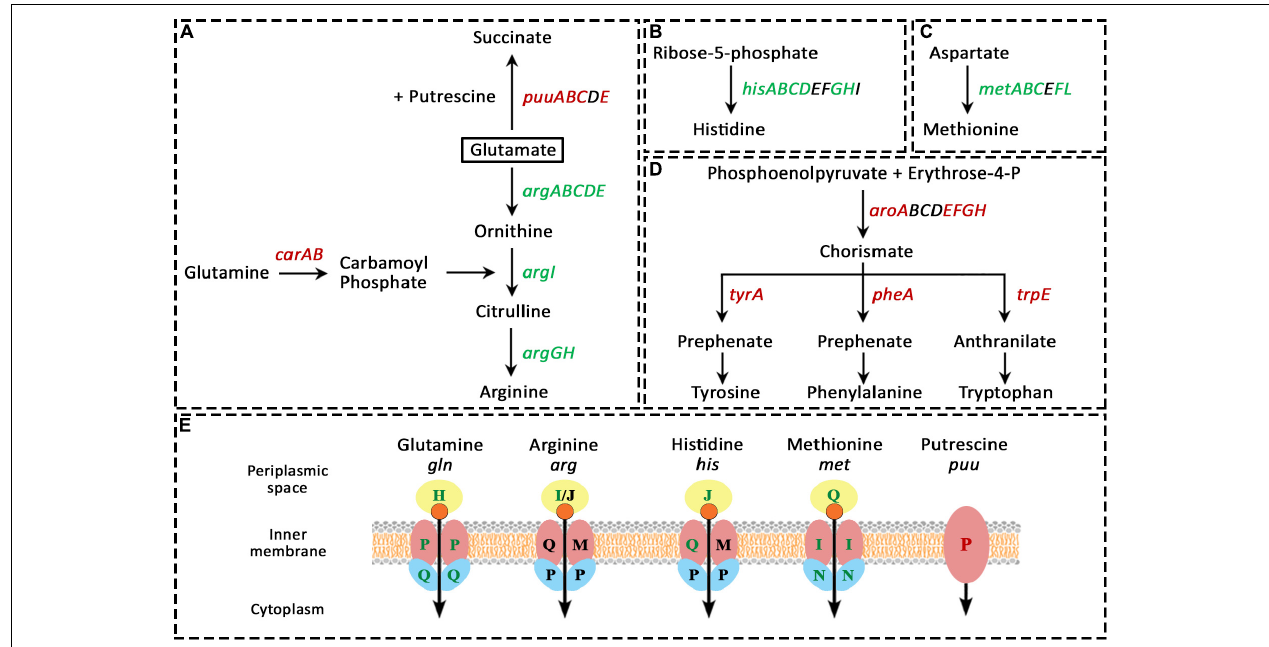
FIGURE 4 | Amino acid-related pathways that were heavily modulated due to Pd stress. In panels (A–D) , green gene names represent up-regulated genes, red names represent down-regulated genes, and black names represent unaffected genes. In figure (E) , green, red, and black letters represent up-regulated, down-regulated, and unaffected genes, respectively. (A) , arginine biosynthesis from glutamate ( argABCDEGHI ) was highly up-regulated, but the biosynthesis of arginine from glutamine was down-regulated ( carA and carB genes). The conversion of glutamate and putrescine to succinate by the products puuABCDE genes was also heavily down-regulated. The biosynthesis of histidine (B) and methionine (C) was also highly up-regulated. (D) , the biosynthesis of aromatic amino acids was drastically down-regulated on two levels, firstly, thought the down-regulation of the production of their common precursor (chorismate) from erythrose-4-phosphate by the products of aroABCDEFGH genes, and secondly, through the down-regulation of their individual pathways. (E) , the pathways involved in the transport of glutamine, arginine, histidine, and methionine were up-regulated. Lastly, the putrescine importer gene puuP was down-regulated.